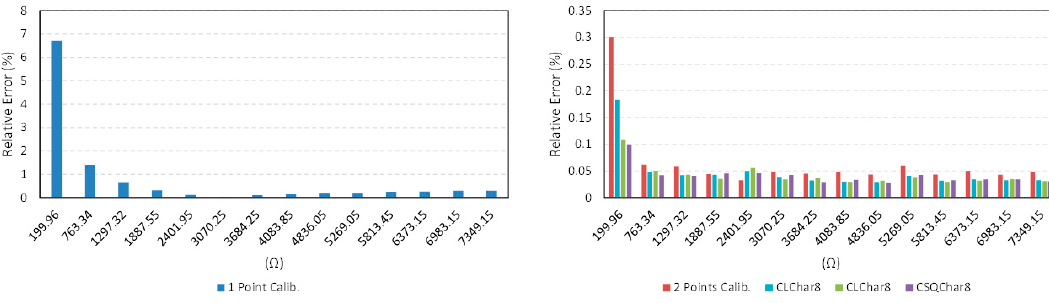
Figure 16. Absolute value of the error for the calibration techniques described in Sections 2.1 and 4.